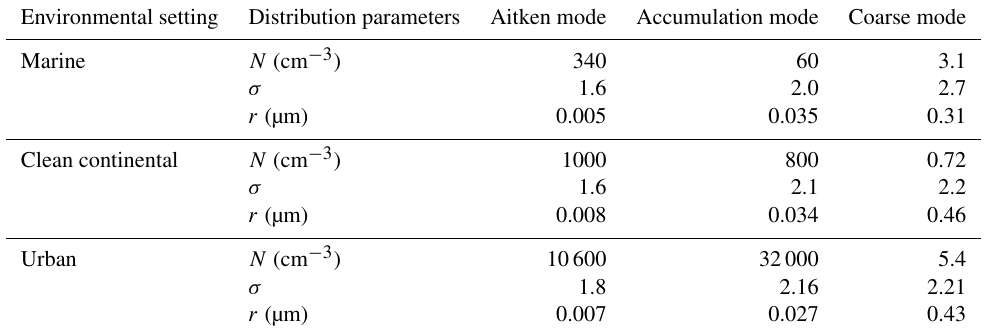
Table 1. Aerosol properties used to test the Shipway and SMOD schemes in the Shipway box model (Whitby, 1978). Environmental setting